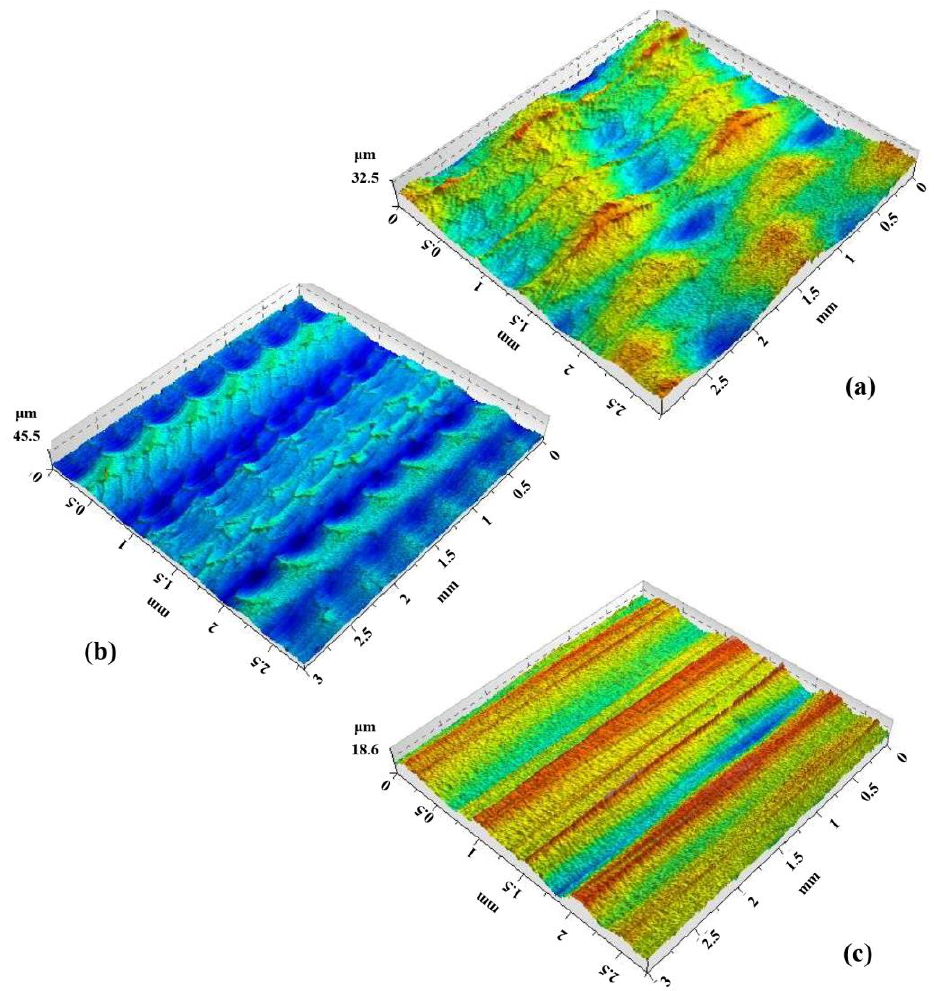
Figure 4. stiffening rib topographies at ( a ) n = 300 rpm, f = 300 mm/min; ( b ) n = 1500 rpm, f = 3000 mm/min; ( c ) n = 1500 rpm, f = 300 mm/min.